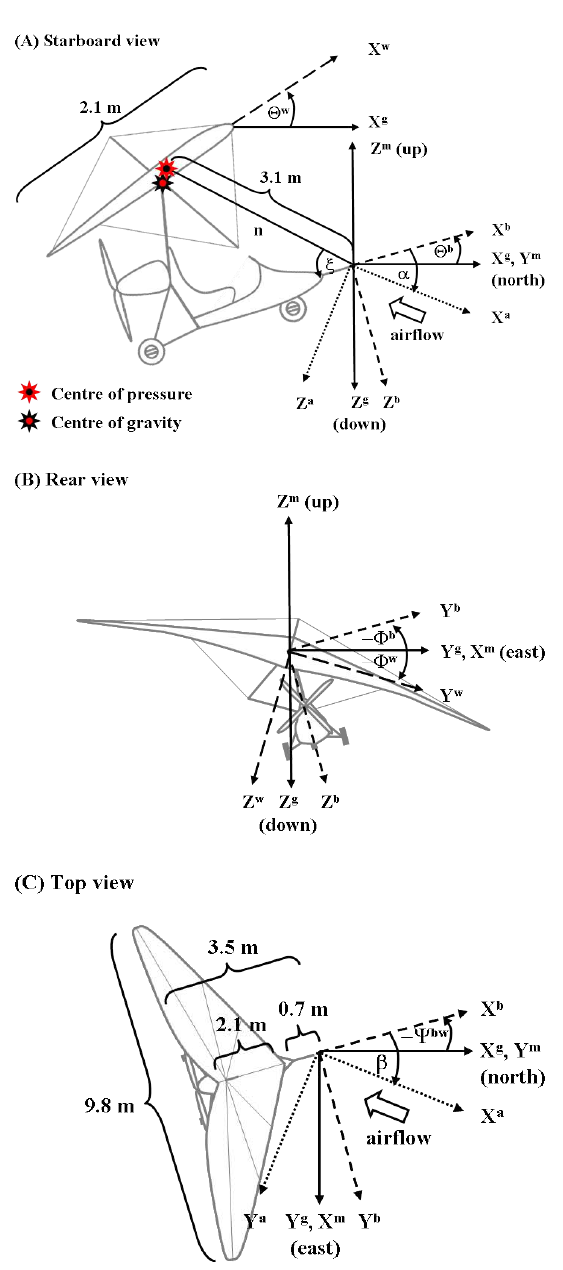
Fig. 2. Geometrical features of the weight-shift microlight aircraft and coordinate systems with axes X, Y, and Z used to compute the wind vector. The superscripts a, b, g, m and w represent, re- spectively, the aerodynamic-, body-, geodetic-, meteorological and wing coordinate systems (Supplement A). (A) Starboard view: An- gle of attack ( α ), pitch angle ( 2 ), normalized radius ( n ), wing up- wash direction ( ξ ), centre of gravity and centre of pressure. Con- tinued on next page: (B) Rear view: Roll angle ( 8 ); (C) Top view: Sideslip angle ( β ) and true heading ( 9 ). In addition the distances between five hole probe measurement and the inertial navigation system (0.7m) and propeller (3.5m), as well as the wing’s chord length (2.1m) and wingspan (9.8m) are